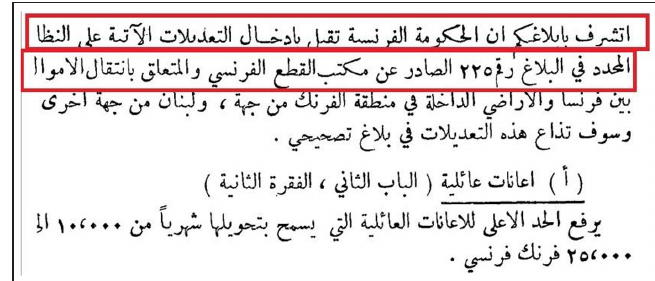
Figure 29: Missed line segments (from outside contractor accuracy